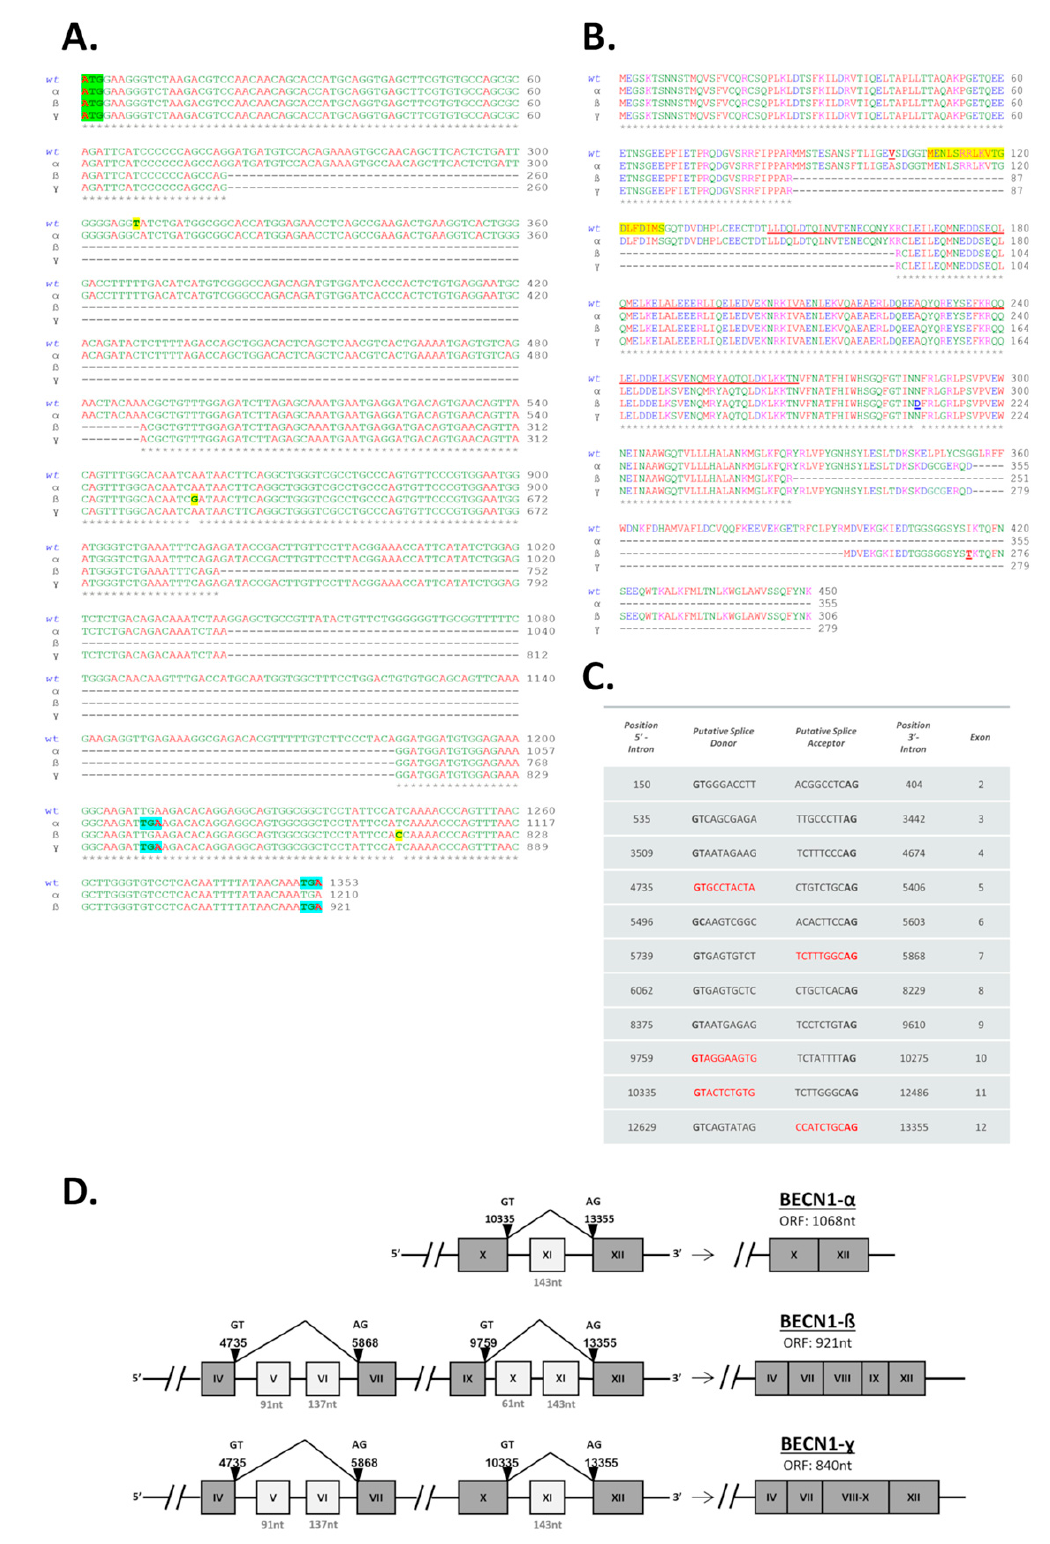
Figure 2. Sequencing analysis of BECN1 transcript variants. ( A ) Multiple sequence alignment of the nucleotide coding sequences of the BECN1 isoforms (wt, α , β , and γ ) isolated from